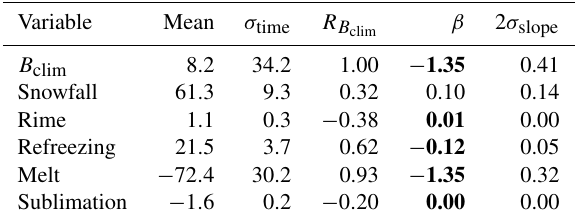
Table 4. Climatic mass balance components in cmw . e . yr − 1 aver- aged over all glaciers in Svalbard for the period 1957–2014 and standard deviation ( σ time ) of the temporal variability, temporal cor- relation with B clim ( R B ), trend slope ( β ) in cmw . e . yr − 2 and clim slope uncertainty (2 σ slope ). Slope significance at the 95% level in bold font ( | β | > 2 σ slope ).